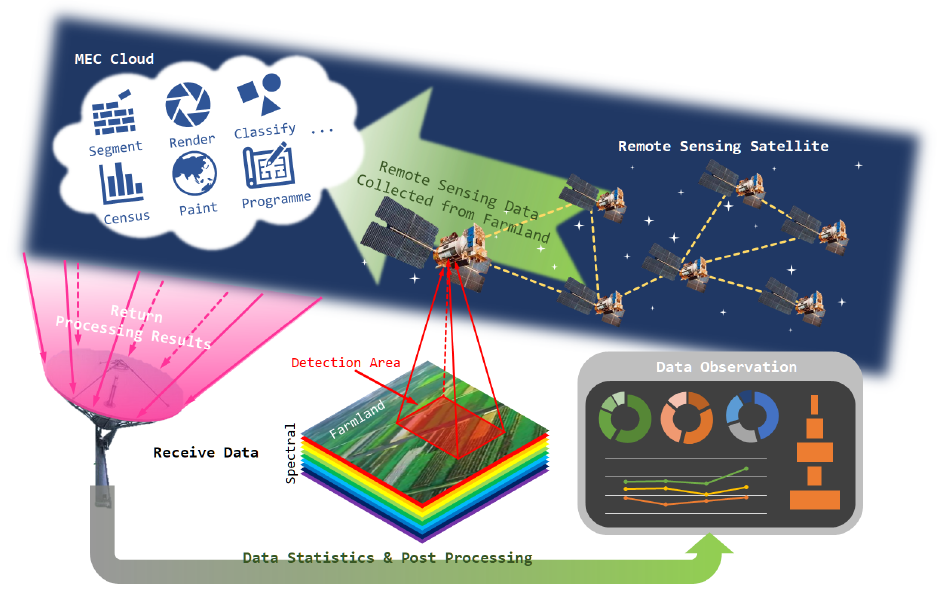
Figure 1. The satellite Internet of Things system. With a prominent role in hyperspectral image classification, which is the core part of edge computing process, attribute profile (AP) [3] can use available attributes that can be calculated based on region to realize multi-scale analysis of images. AP is considered a multi-scale analysis tool, which can filter the connected components of gray image rather than single pixel executed by morphological attributes. In addition, in the case of limited sample numbers, high-quality samples for classifiers can also be generated by AP- based algorithms. Due to the high dimension of hyperspectral image data, the dimension reduction process before attribute filtering is common in hyperspectral images, which often leads to the loss of spectral information. Stacked filtered images are called extended attribute profiles (EAPs). As shown in [3–5], spatial information of connected region at different scales can be modeled by APs. Therefore, the multi-level spatial features of images can be created by applying APs in sequence, which make APs an effective spatial feature of hyperspectral data. As the [6,7] show, when EAPs combined with original spectral data is used as the input samples of the network, the extracted features of the network are better for classification, reflecting the great cooperation potential of combining EAP and deep learning. Also, seeing that images can be processed based on different attributes and thresholds which first can be calculated based on the connected components, AP can be used as a flexible tool. The traditional thresholds are set arbitrarily, but the tuning of the parameters of the attribute filter is rarely studied. In [8], an automatic feature selection method is proposed to tune the thresholds of attribute filters. Dalla [9] proves that